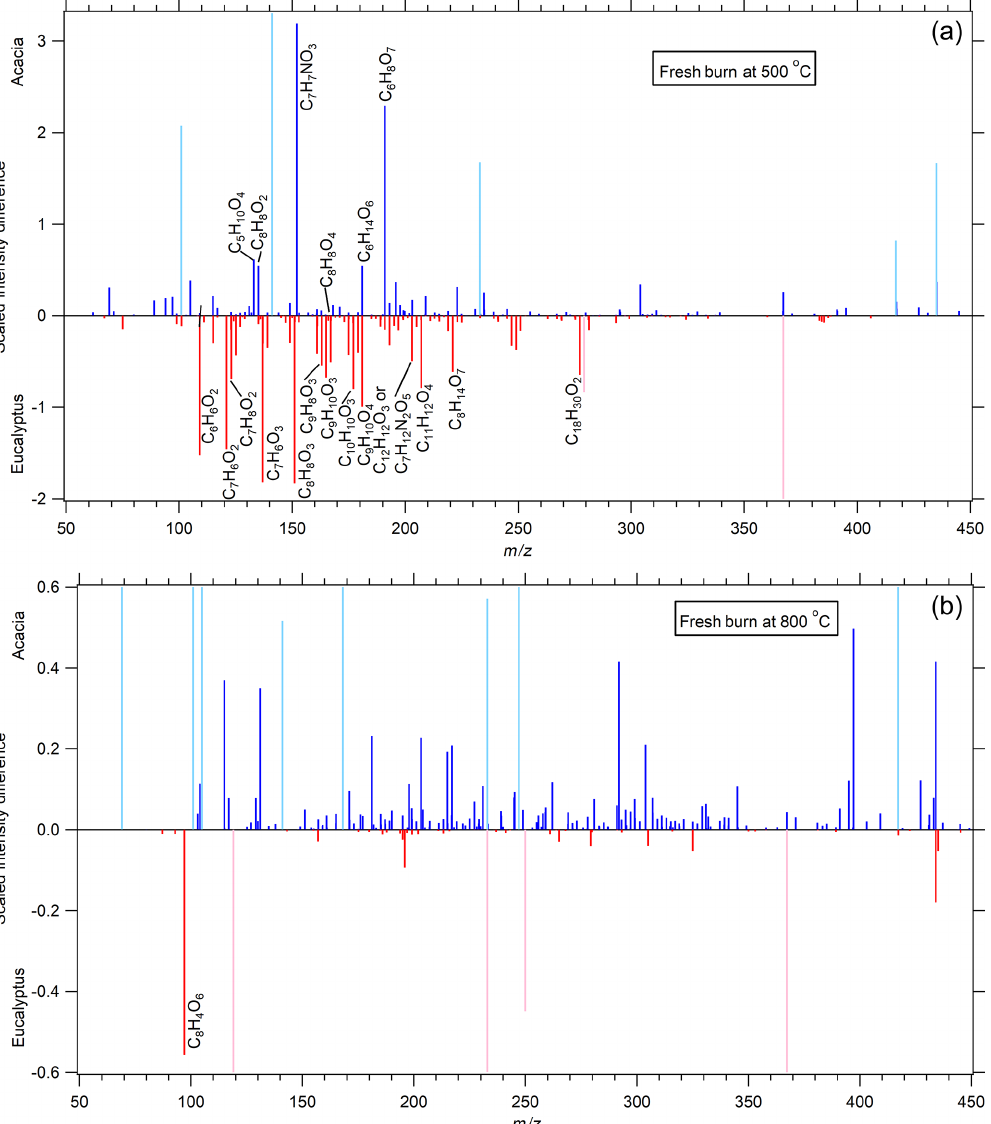
Figure 1. A comparison of fresh acacia and eucalyptus fuels combusted at 500 ◦ C (a) and 800 ◦ C (b) in terms of the scaled intensity difference (see Sect. 2.5). Species more present in acacia-derived BB aerosols have positive values (blue lines), while those more present in eucalyptus-derived BB aerosols have negative values (red lines). Peaks in lighter colors were present in the XCMS analysis but were found to be present in significant amounts in the blank sample. Many of these peaks that were found in the blank extend past the scale of the plot but were cut off to focus on species associated with BB aerosol. Compounds having an absolute difference greater than 0.5% have been labeled. Far more differences are revealed at the lower-temperature burn, and different classes of compounds are expressed in different relative amounts for acacia and eucalyptus